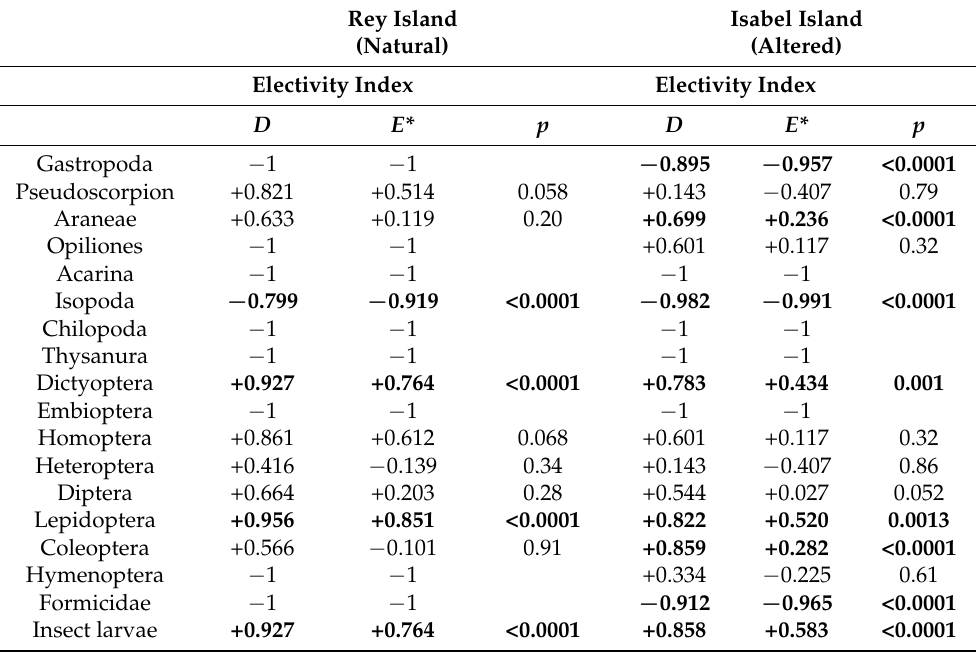
Table 4. Prey selection by the Moorish gecko, Tarentola mauritanica , in two of the Chafarinas Islands with different levels of anthropogenic disturbance (natural: Rey; altered: Isabel). The electivity index of Jacobs ( D ) and the Vanderploeg and Scavia’s relativized electivity index ( E* ) are given for each potential prey type. The statistical significance ( p from a χ 2 test) of this E* index is given. Significant electivities are marked in